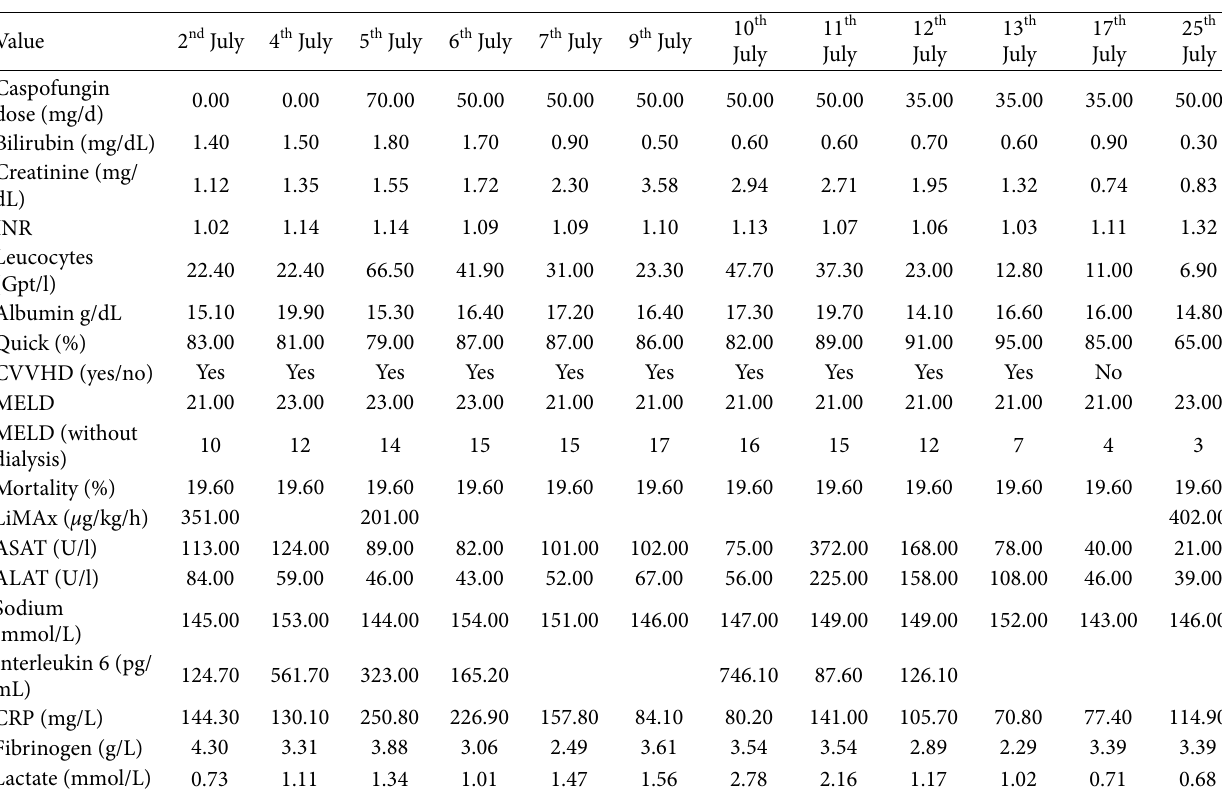
Figure 2: LiMAx measurements over time. Table 1: Course of laboratory